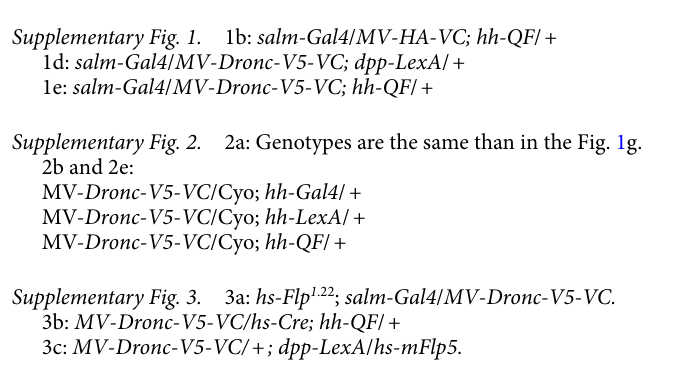
Figure 2. 2a: hs - Flp 1 .22 ; salm-Gal4 / MV - Dronc-V5-VC